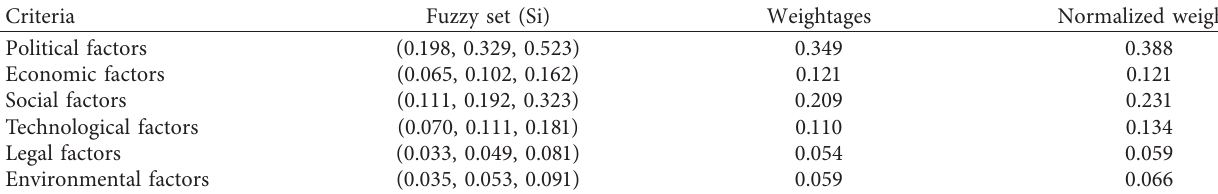
Table 3: Weights computed from the fuzzy AHP.